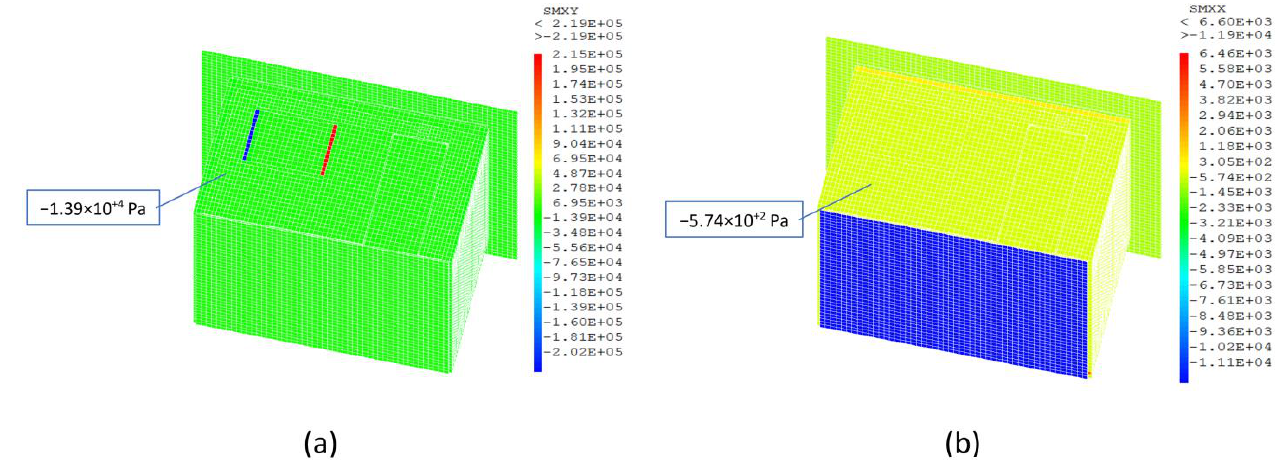
Figure 20. Stress distribution on the envelope of the EEBLAB: ( a ) normal stress ( b ) shear stress.